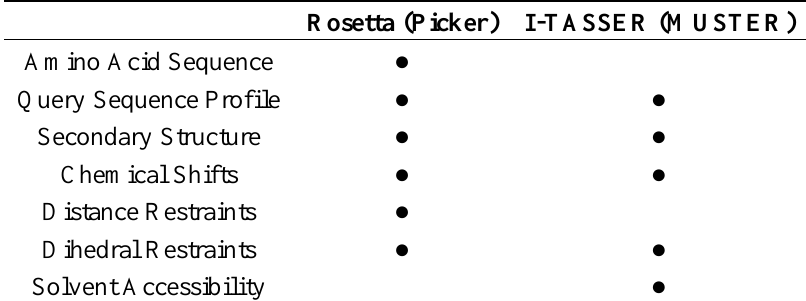
Table 3. Scoring criteria of two fragment generators.